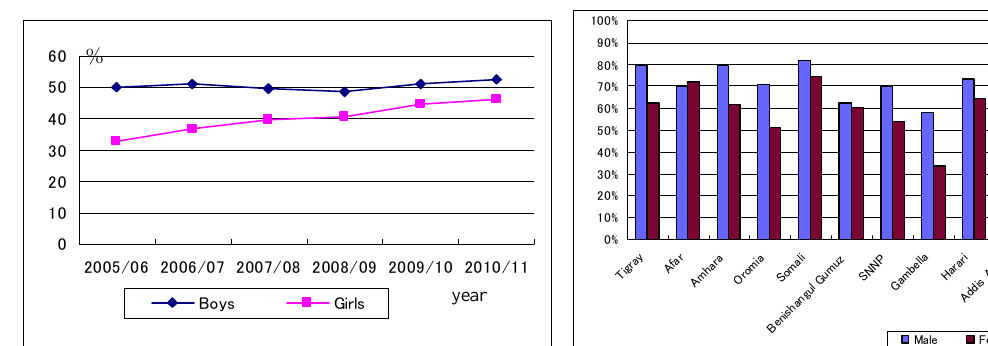
Figure 4-2: Primary Gross Enrollment Rate Figure 4-3: Primary Repetition Rate by